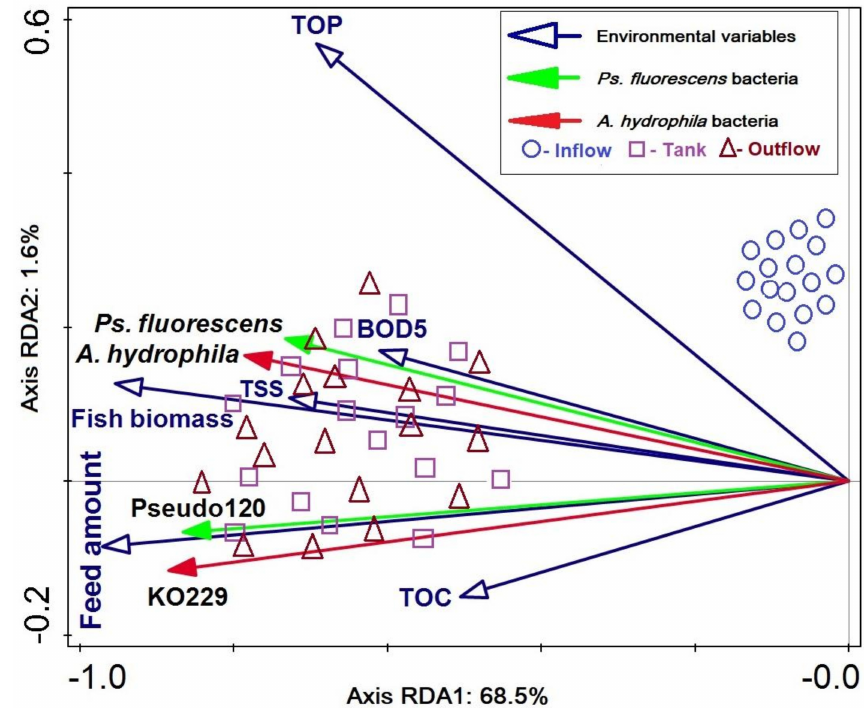
Figure 4. Redundancy analysis (RDA) biplot of the correlations (p ≤ 0.05) between Pseudomonas fluorescens and Aeromonas hydrophila counts and environmental variables determined by culture-dependent and culture-independent methods (Peudo120, KO 229) in samples of RAS water during intensive rearing of European grayling ( Thymallus thymallus L.)